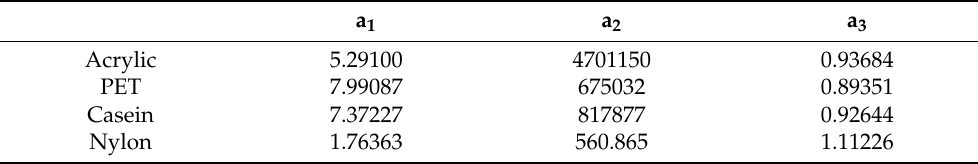
Table 6. Parameters of regression equation by Equation (23).